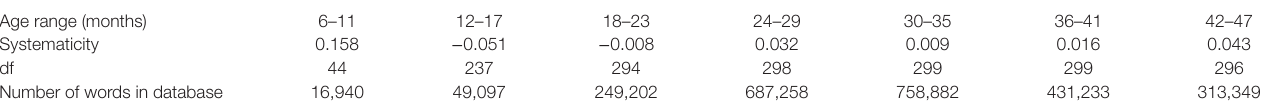
Note that the number of words occurring in the ChildFreq database in the last row is due to the different sample sizes at the different age ranges. Note further that the differences in degrees of freedom (df) reflect cases in which one of the independent variables was not defined for a word, or a word did not occur in the database and the log 10 transformation is undefined and therefore not included in the